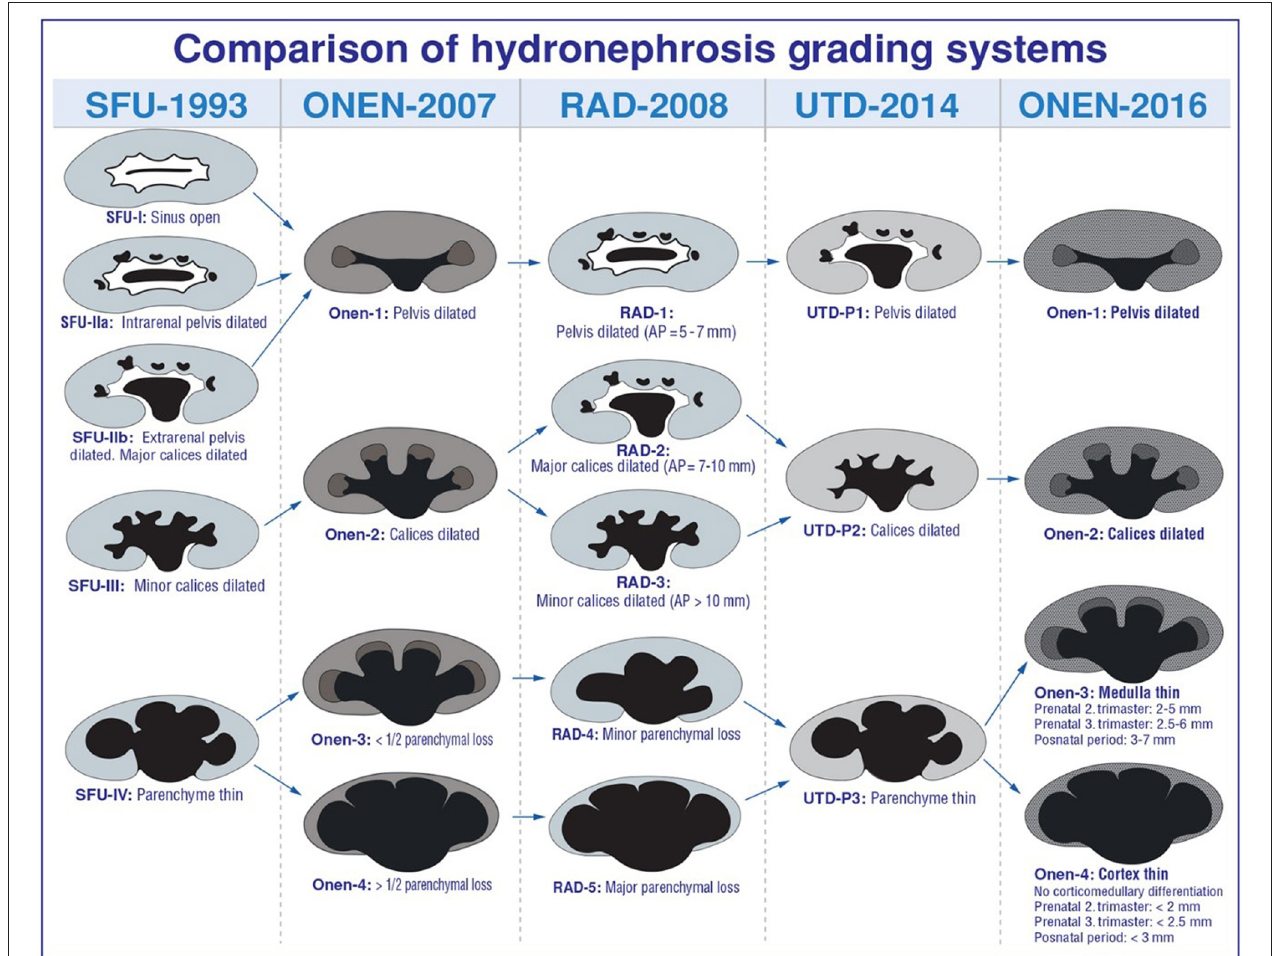
FIGURE 5 | Comparison of hydronephrosis garding